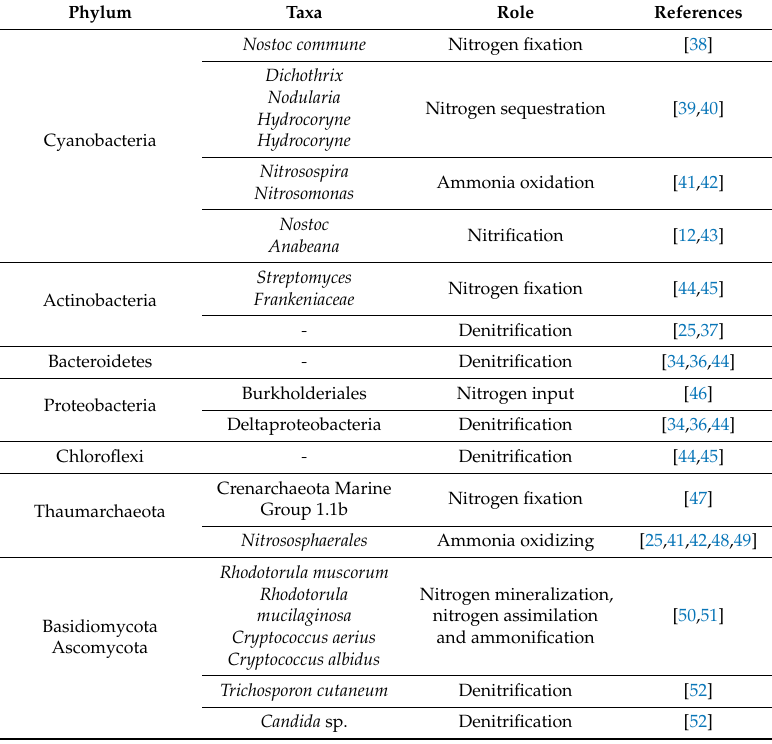
Table 2. Summary of microorganisms participating in nitrogen